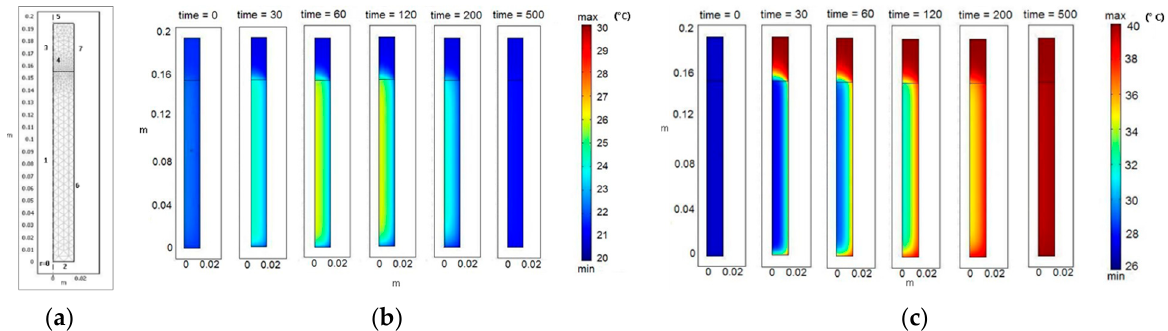
Figure 4. ( a ) Schematic view of the domain with unstructured mesh used in the simulation. Temperature distribution in the bed during hydrogen absorption ( b ) and desorption ( c ) processes at different times (in seconds).